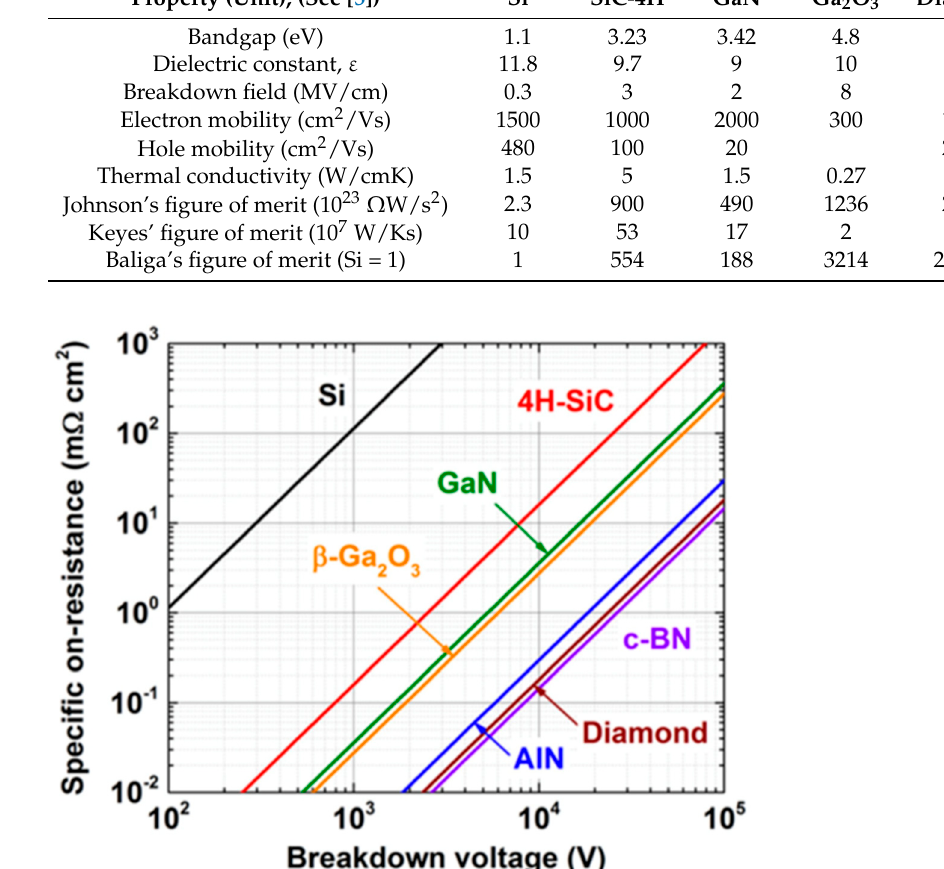
Figure 1. ON-resistance and breakdown voltage of the different semiconductors at room temperature. Note that at high temperature diamond improves its characteristics (Reproduced with permission from Pearton et al. [5] Copyright 2021 ©AIP Publishing)